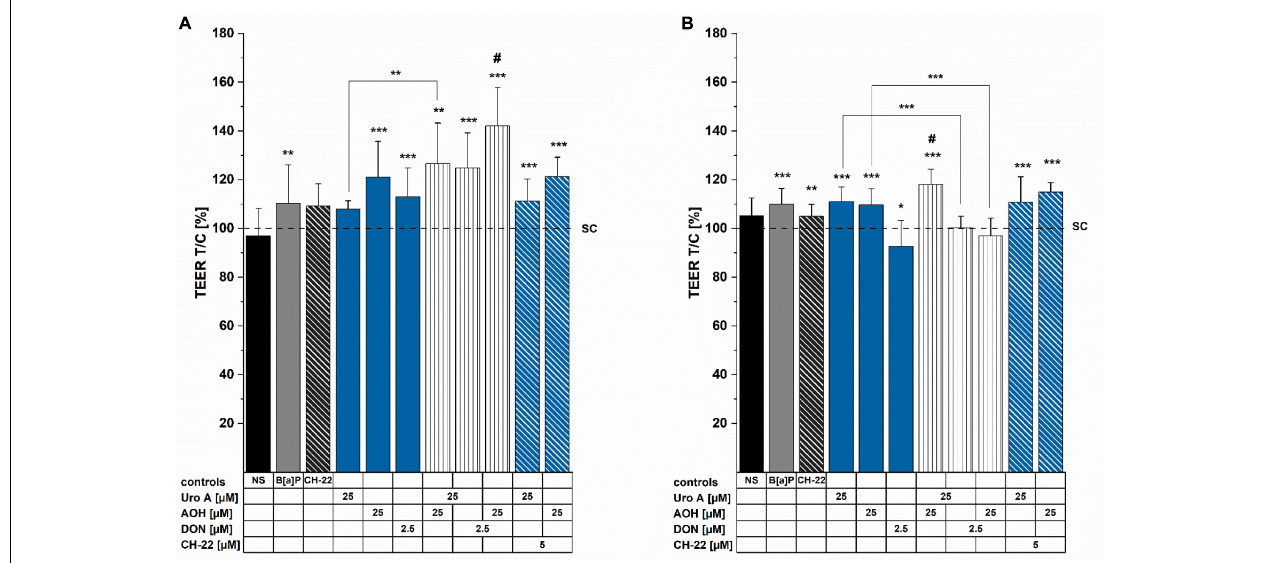
FIGURE 4 | Transepithelial electrical resistance (TEER) measurements were conducted after (A) 24 h and (B) 48 h of incubation. TEER REPORTED values were normalized to the solvent control condition and are presented as percentages. Significant differences were calculated applying two-samples Students’ t- test, at * p < 0.05, ** p < 0.01, *** p < 0.001; # p < 0.05 represents significant differences of binary mixtures compared to the respective single compounds. NS ˆ= no solvent